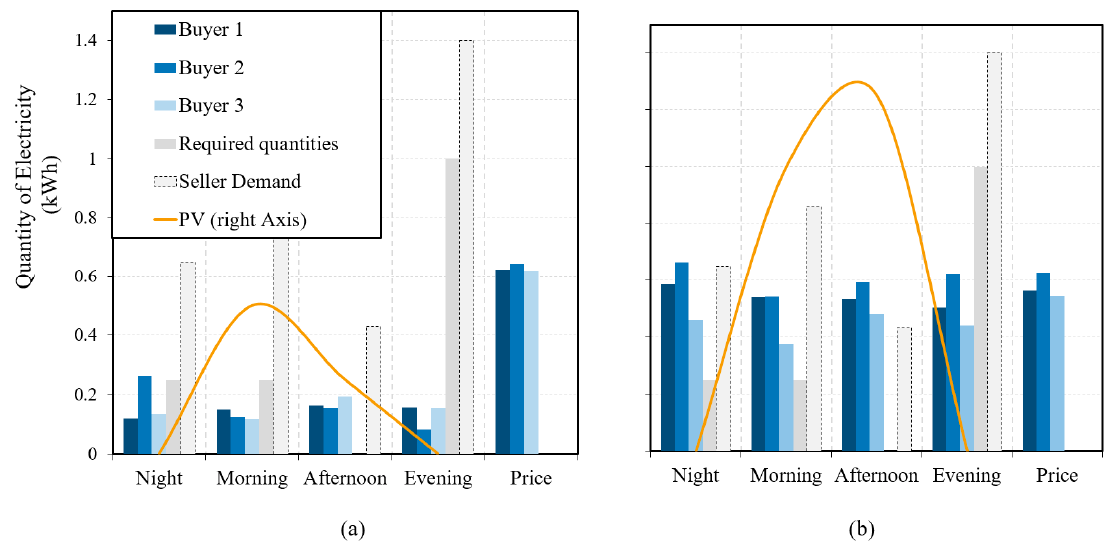
Figure 2. Outcomes of negotiations for the three different types of buyer agents implementing a ZI strategy against the seller, also implementing a ZI strategy, for the case of a cloudy day ( a ) and of a sunny day ( b ).